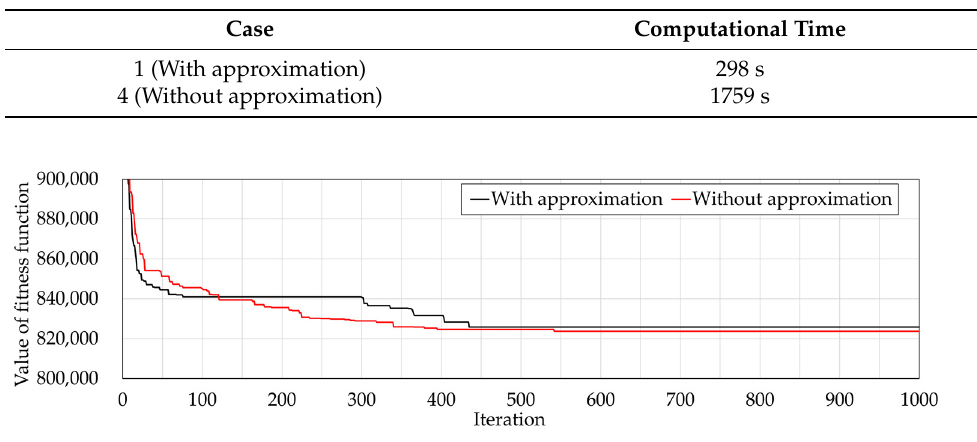
Table 4. Comparison of computational time of Cases 1 and 4.